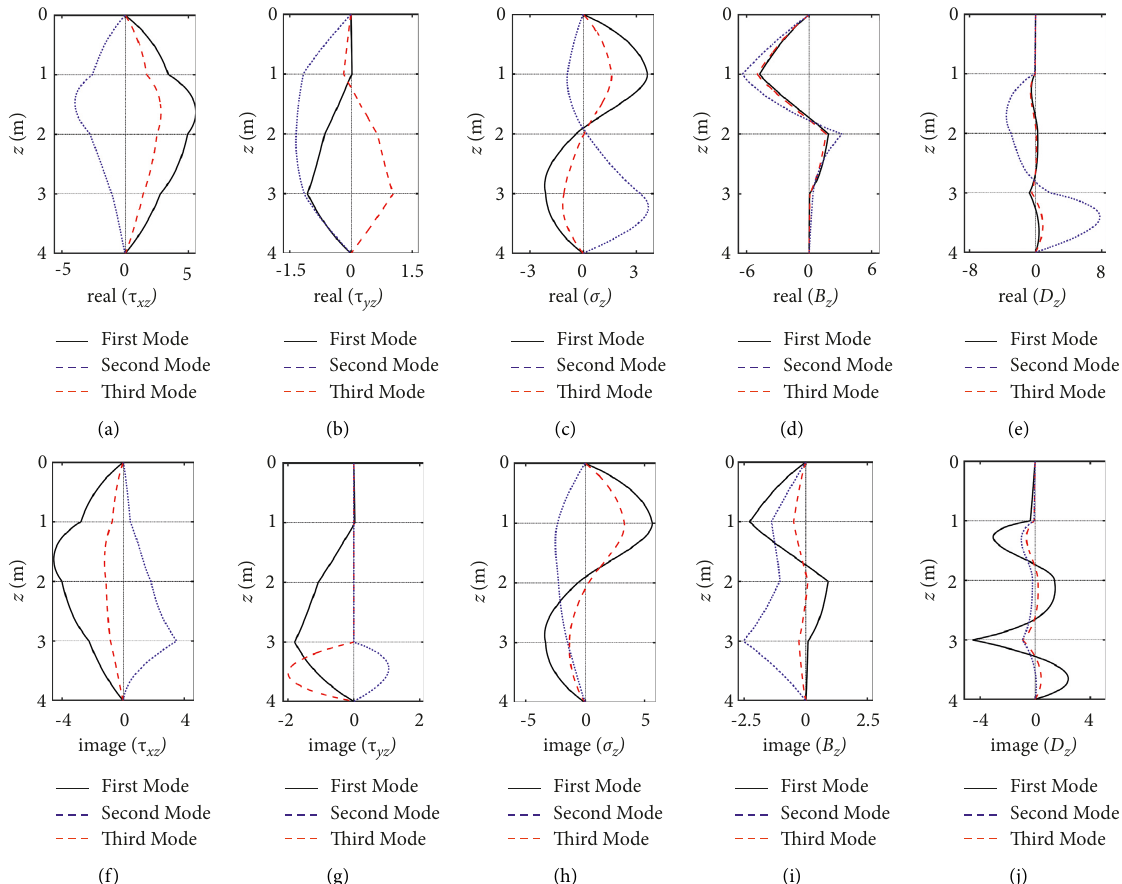
Figure 7: The stress components, electrical and magnetical displacements of guided waves in the four-layered plate for the first three modes. Table 3: At κ H � 2, the first five frequencies ω (rad · μ s − 1 ) of this method and the SAFE method for four types of boundary conditions.